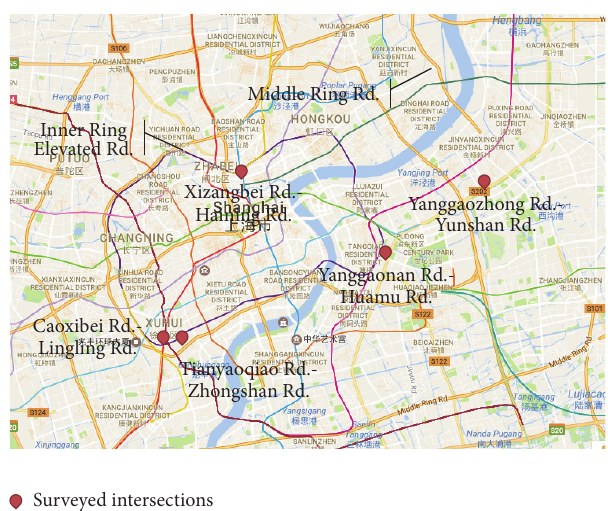
Figure 1: Target intersections with dynamic lane assignment in Shanghai, China.